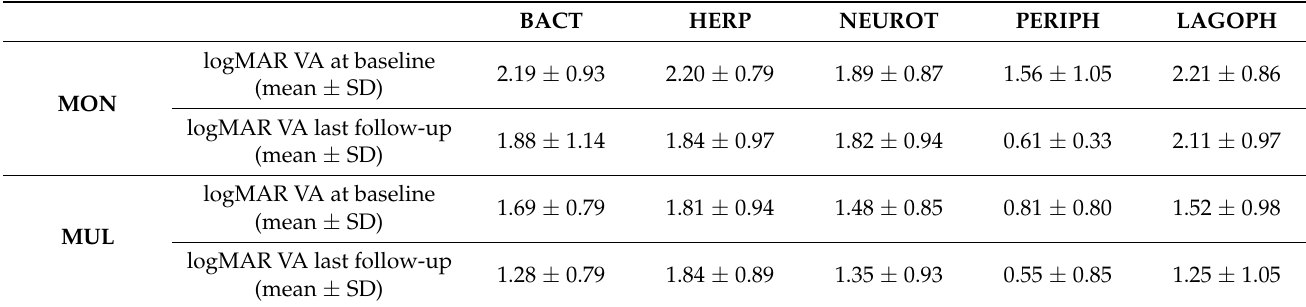
Table 4. Relationship between the number of amniotic membrane layers and visual acuity gain according to ulcer etiology.